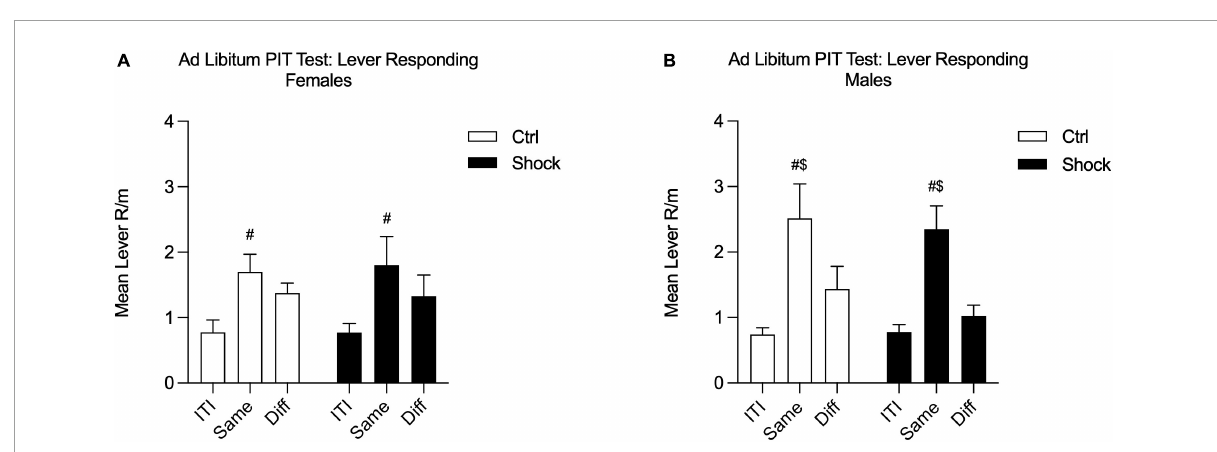
FIGURE7 Ad libitum SS-PIT test in Ctx B in Experiment 2. (A) In females, the sensory-specificity of transfer was abolished in this ad libitum testing; Same and Different lever responses did not differ in either the Ctrl or Shock female groups. Same lever responses were greater than ITI in both groups. (B) In males, SS-PIT was maintained under ad libitum test conditions and Same responding was significantly greater than Different lever responding ( $ Same vs. Diff, p < 0.05; # significantly greater than ITI, p <